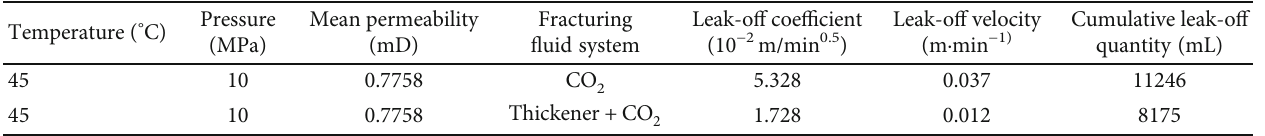
fracturing fl uid. 2